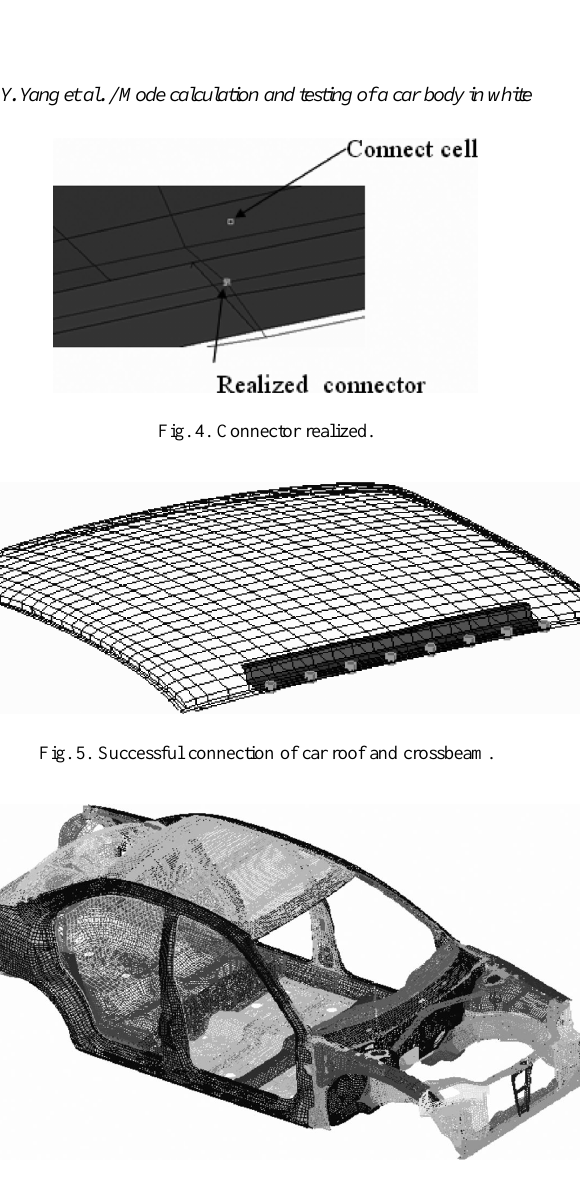
Fig. 6. Finite element model of